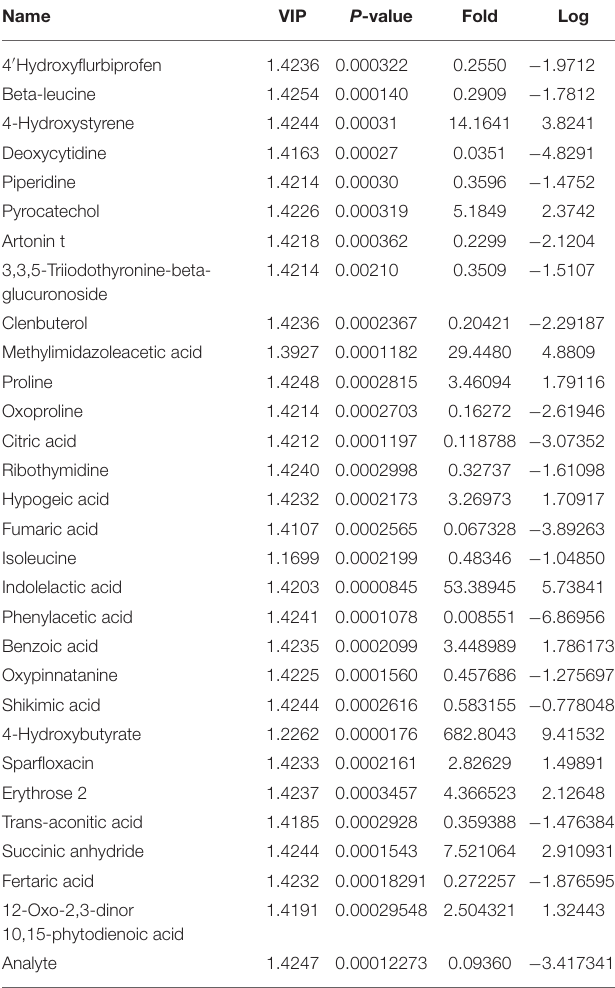
TABLE 2 | The variations in P. notoginseng leaves metabolites after